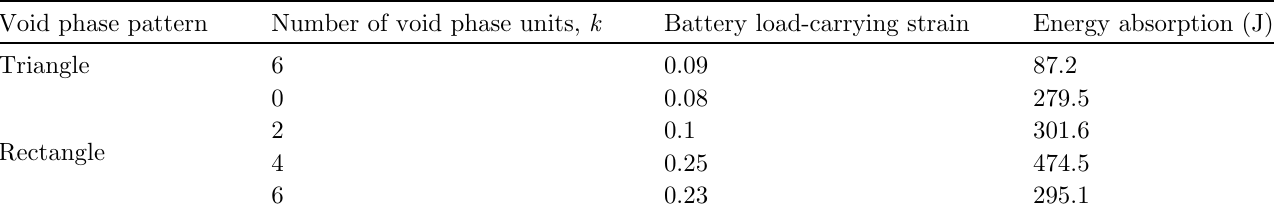
Table 2. Effects of void shape and number on battery